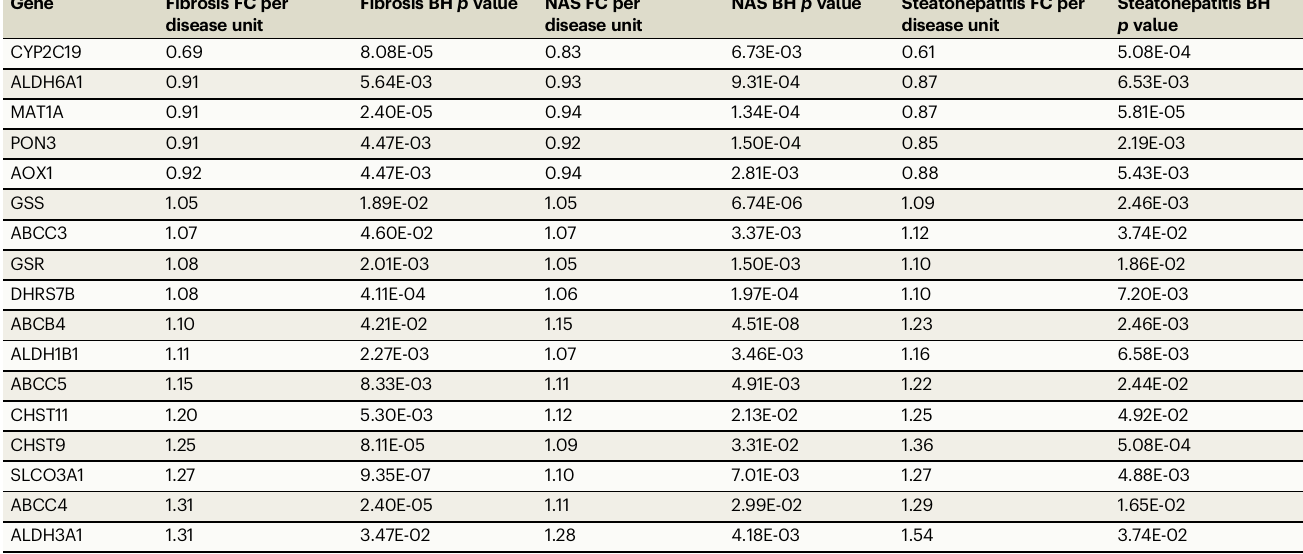
Table 3 | Regression estimates for the 17 pharmacogenes commonly changed in all 3 disease subgroups, converted to percent fold change per disease